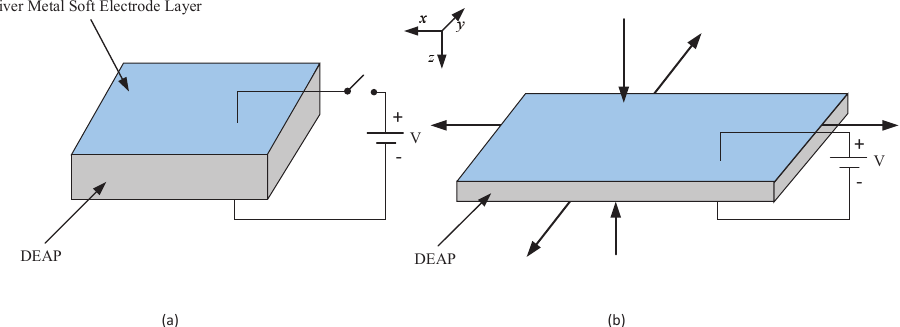
Figure 1. The working principle of dielectric electro-active polymer (DEAP) materials. ( a ) Power cut: Initial state of DEAP materials. ( b ) Power supply: Actuation direction of DEAP